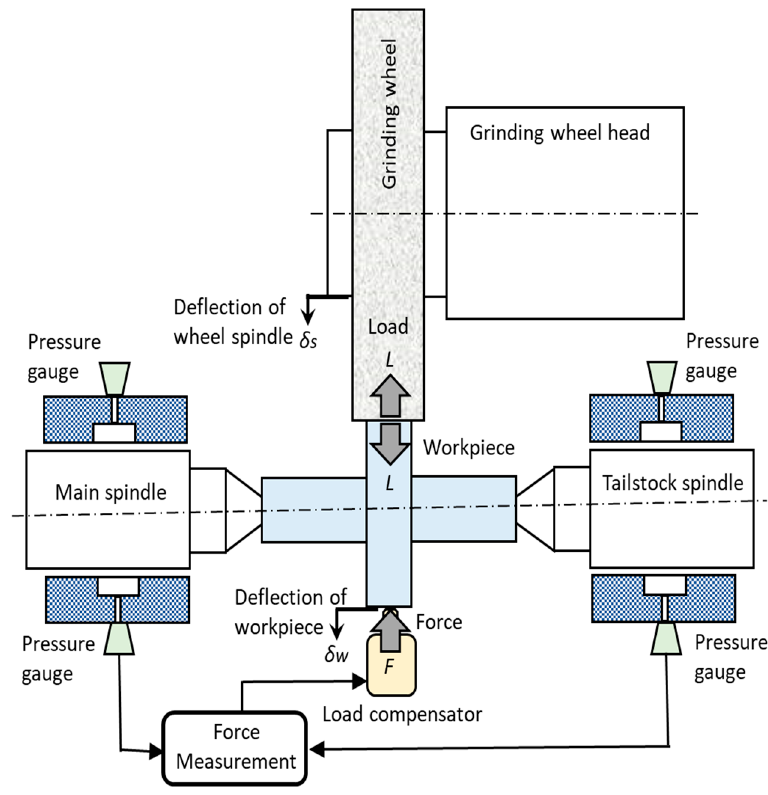
Figure 8. Experimental setup.